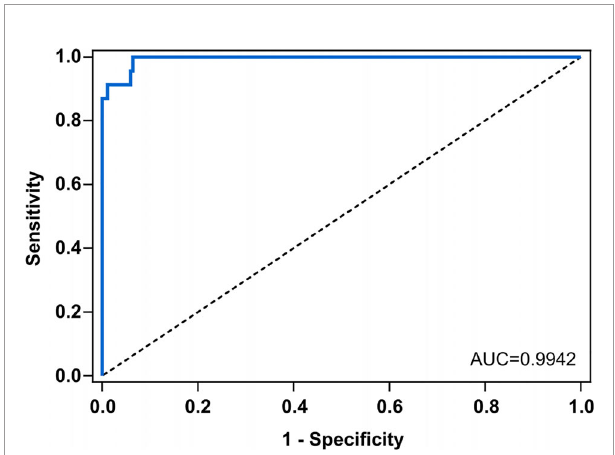
FIGURE 7 | Receiving operating characteristics curve (ROC) for anti – Scedosporium boydii Total WCP IgG ELISA. Scedo+ patients vs. negative patients (Asp+ and Scedo-/Asp-). The area under the curve (AUC) for S. boydii- speci fi c IgG was 0.9924. Line of identity is indicated with the dashed